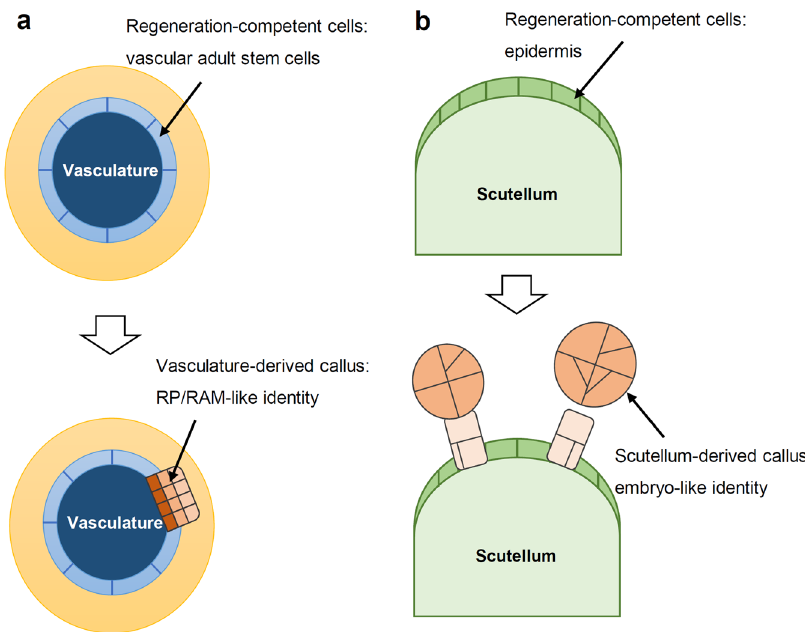
Fig. 6 Model of callus initiation in rice. a , b Vasculature-derived callus initiation adopts a root developmental program ( a ), and scutellum-derived callus initiation might adopt a embryo developmental program ( b